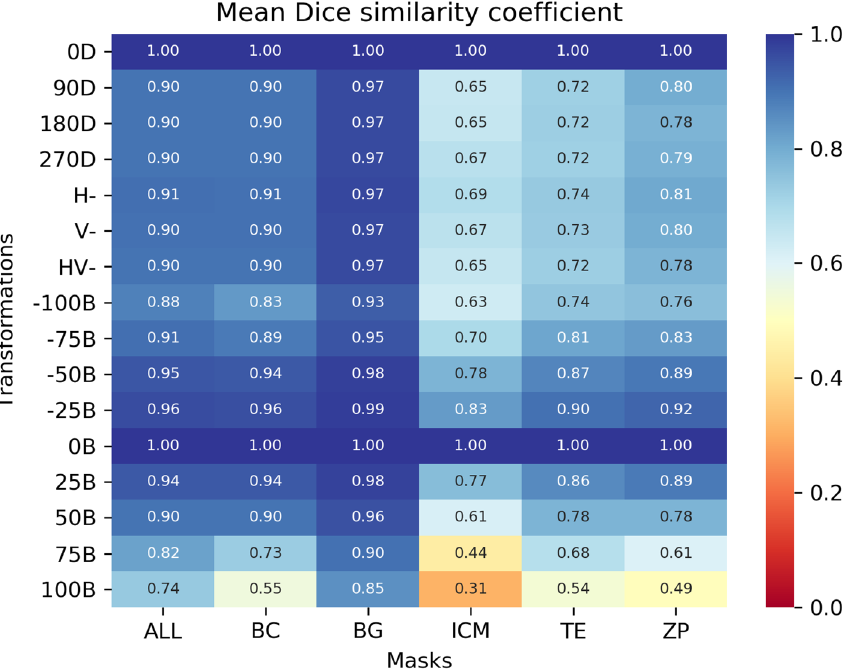
Figure 3. Mean DSC for the regions of interest (x-axis) between the original blastocyst mictrographs and their transformations (y-axis) of the segmentation result. 0D, 90D, 180D, and 270D represents the rotational degrees transformation. H-, V-, and HV- represent horizontal, vertical, or both flip transformations. −100B to 100B represent the absolute value of the brightness transformation. BC Blastocoel, BG Background, ICM Inner cell mass, TE trophectoderm, ZP zona pellucida, All all the regions of